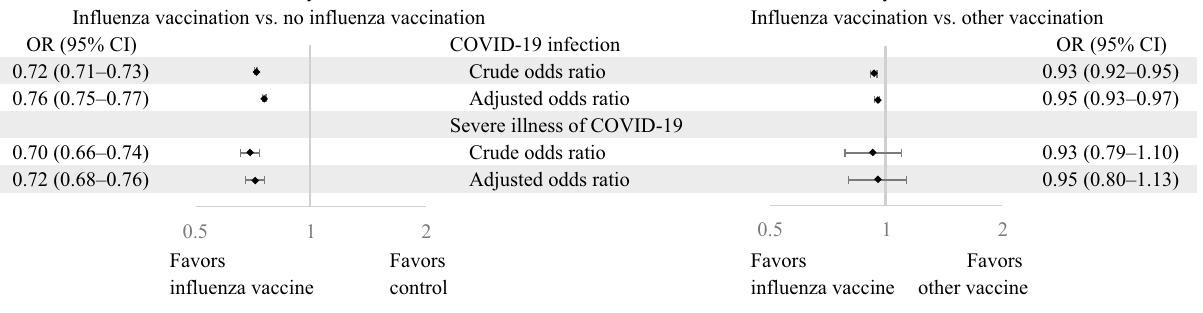
Figure 3. Effectiveness of influenza vaccine for protection against COVID-19 infection and severe COVID-19 illness. OR, odds ratio; CI, confidence